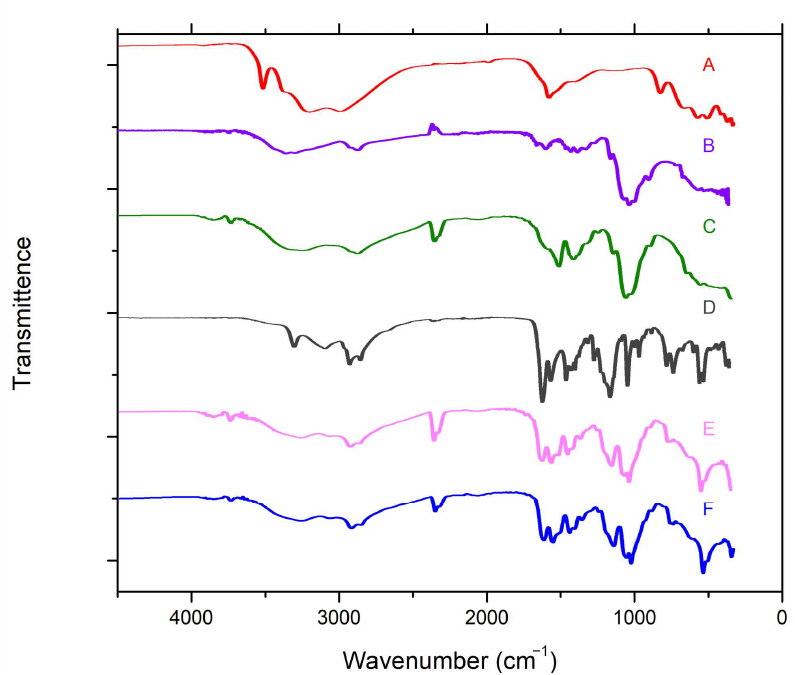
Figure 2. IR spectrum of FeCl 3 ×6H 2 O ( A ); IR spectrum of chitosan ( B ); IR spectrum of POX-1 ( C );